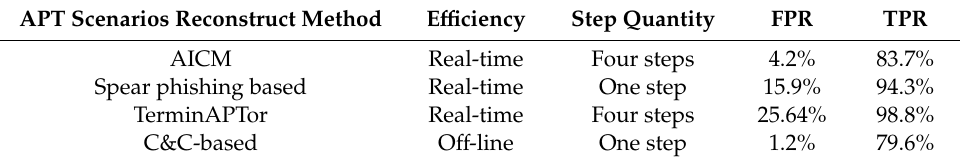
Table 6. The comparative results between AICM and other APT scenarios reconstruction